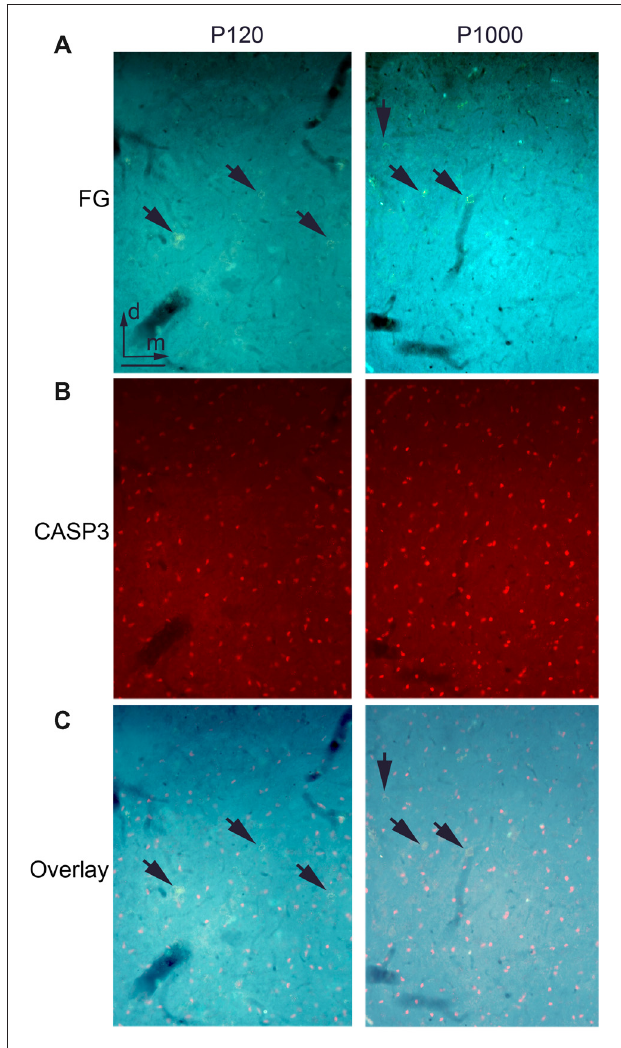
FIGURE 4 | There is no ongoing apoptosis of projection neurons in elderly animals. (A) Frontal section through the auditory thalamus (dorsal part of the medial geniculate body, MGD) at P120 (left) and P1000 (right) showing retrogradely labeled neurons (golden, arrows) after an injection of FG into A1. (B) Same section showing apoptotic Cysteinyl-aspartate Specific Protease 3 positive (CASP3+) neurons (red). (C) Overlay of (A,B) , FG+ neurons appear golden (arrows), CASP3+ neurons appear pink. Note that there are no double-labeled neurons. Scale bar 25 µ